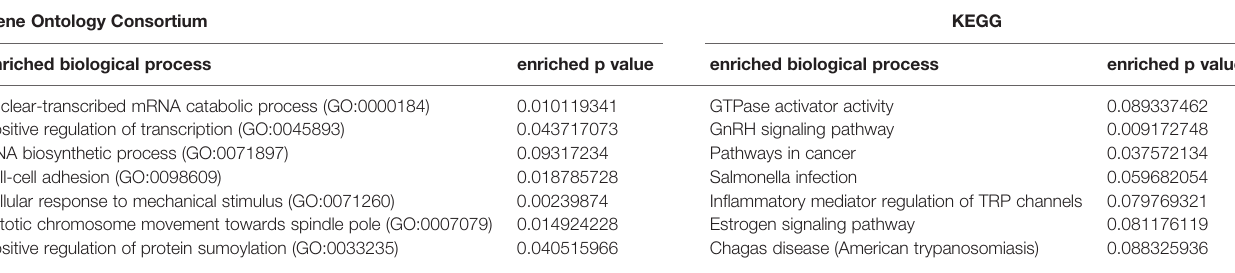
TABLE 2 | The functional enrichment of high-frequency “ sJSD signal biomarkers ” at the critical stage samples for prostate cancer.